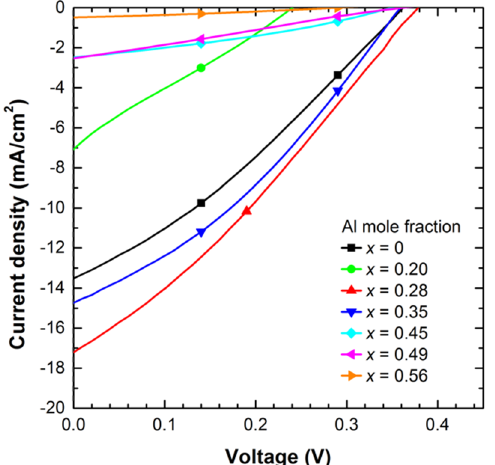
Figure 5. Current density vs voltage curves of the Al x In 1 − x N on Si (100) devices under AM1.5G illumination (1 sun) vs the Al mole fraction x.